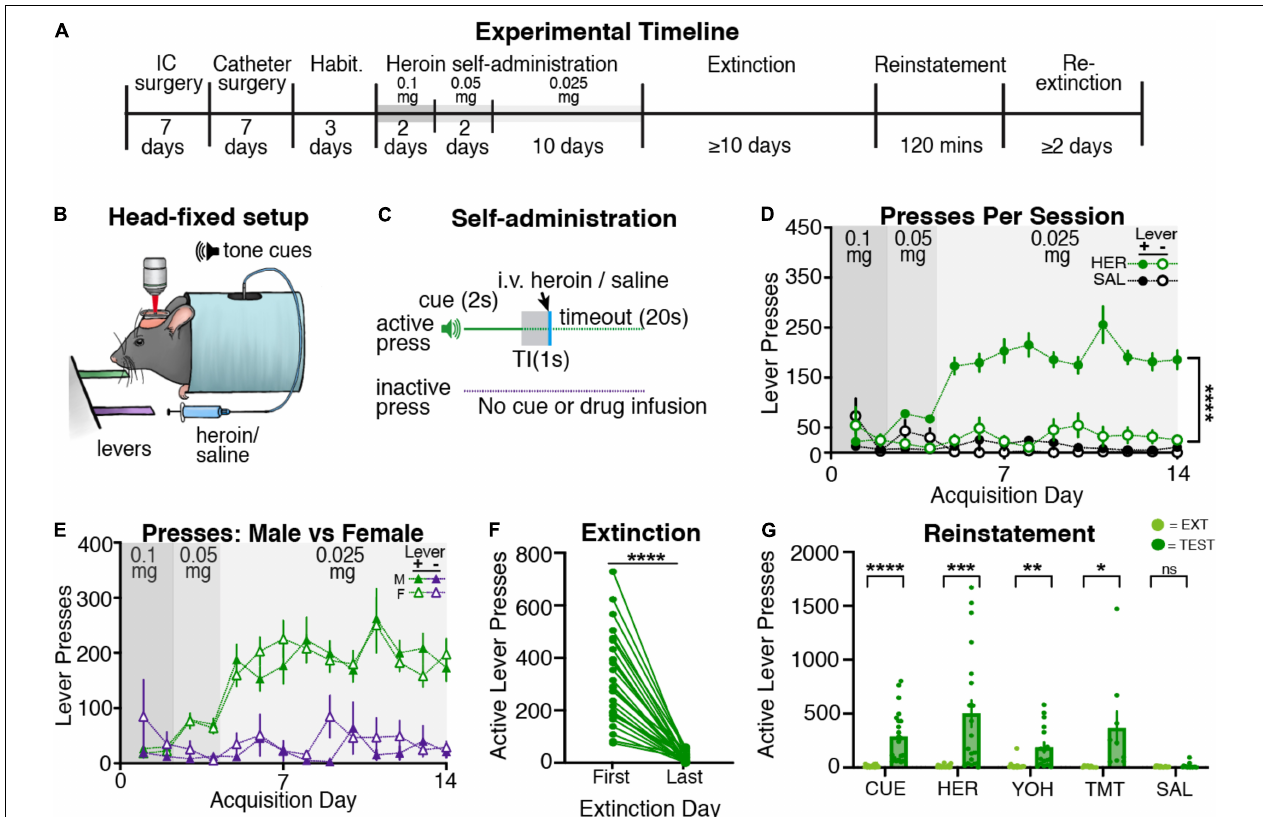
FIGURE 1 | Head-restrained mice self-administer heroin and display extinction and reinstatement of heroin seeking. (A) An experimental timeline demonstrating the behavioral procedure used for head-restrained heroin self-administration. (B) Illustration of head fixation for heroin self-administration experiments. Active lever presses resulted in a tone cue that predicted intravenous heroin [at doses of 0.1 mg/kg (day 1–2), 0.05 mg/kg (day 3–4), or 0.025 mg/kg (day 5–14)] or intravenous saline. (C) Schematic for heroin/saline self-administration experiments, where active but not inactive lever presses resulted in a tone cue (2s), a gap in time (TI, trace interval; 1s), an infusion of heroin or saline, and a timeout period (20s). (D) Data showing that heroin self-administering mice pressed the active lever more than the inactive lever (**** p < 0.001), whereas saline self-administering mice did not. (E) A comparison of active and inactive lever pressing across sexes. Male and female heroin self-administering mice showed no differences in lever pressing across acquisition. (F) During extinction, heroin self-administering mice significantly decreased active lever pressing from the first day of extinction to the last (**** p < 0.001). (G) Data showing that mice displayed cue- (**** p < 0.001), heroin- (*** p = 0.001), yohimbine- (** p = 0.002), and predator odor (TMT; * p = 0.048)-induced reinstatement of active lever pressing as compared with the previous extinction test. Mice did not reinstate following an injection of